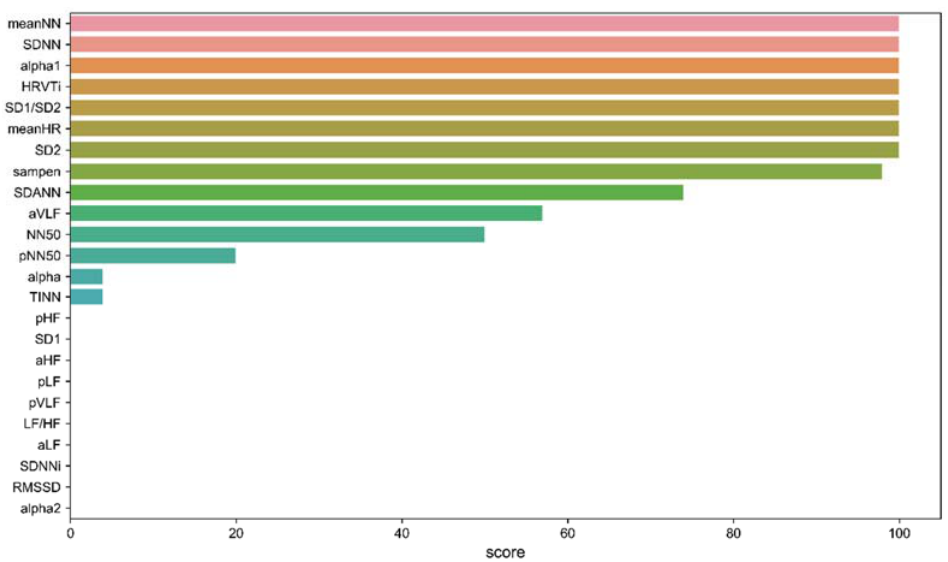
Figure 3. The scores calculated by Equation (4) of all the 24 original features.